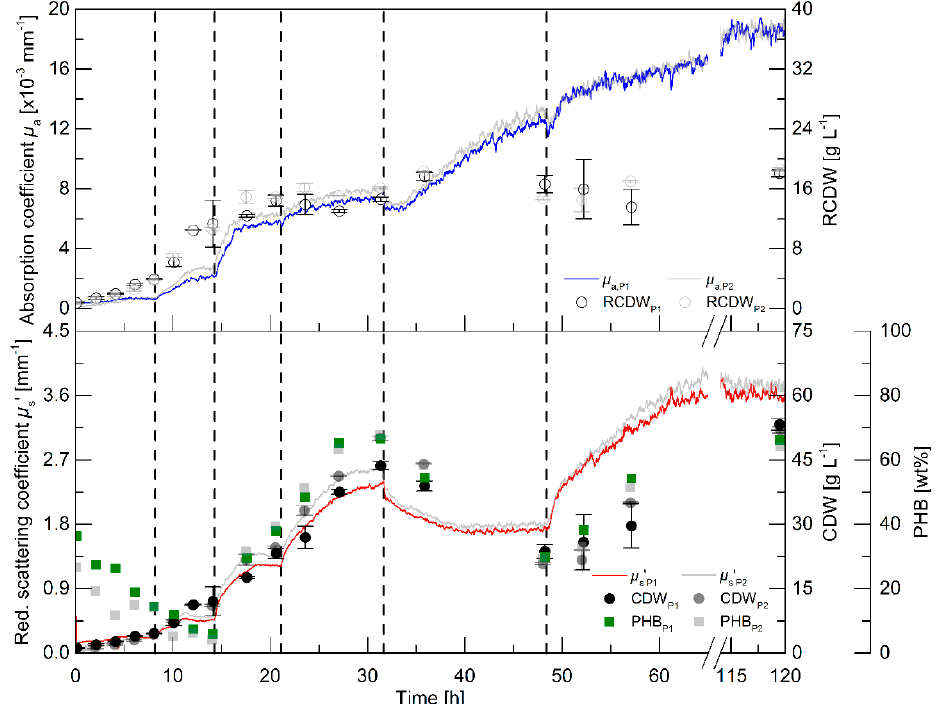
Figure 3. Pulse feeding cultivations for PHB production by R. eutropha H16. The cultures were initially started with 0.5% (w · v − 1 ) rapeseed oil and 4.5 g · L − 1 urea (150 mM nitrogen). The dashed vertical lines represent time points of pulse additions: 0.5% (w · v − 1 ) rapeseed oil at 8.2 h, 1% (w · v − 1 ) rapeseed oil at 14.3 h, and 2% (w · v − 1 ) rapeseed oil at 21.1 h. At 31.7 h a bolus consisting of 110 mL urea solution (122 g · L − 1 ), 15.6 mL 0.5 M K 2 SO 4 , 30 mL 0.32 M MgSO 4 , 30 mL 0.042 mM CaCl 2 , and 3 mL trace element solution was added to the bioreactor. A final bolus of 4% (w · v − 1 ) rapeseed oil was added at 48.4 h. Data from the reference experiment is shown in color (indexed P1) and the biological duplicate (with an independent seed train) in transparent grey (indexed P2). Absorption coe ffi cient µ a (upper graph, solid line, × 10 − 3 mm − 1 ), RCDW (upper graph, empty circles, g · L − 1 ), PHB content (bottom graph, squares, wt%), CDW (bottom graph, filled circles, g · L − 1 ), and reduced scattering coe ffi cient µ s ’ (bottom graph, solid line, mm − 1 ) are shown. Error bars indicate minimum and maximum values of technical